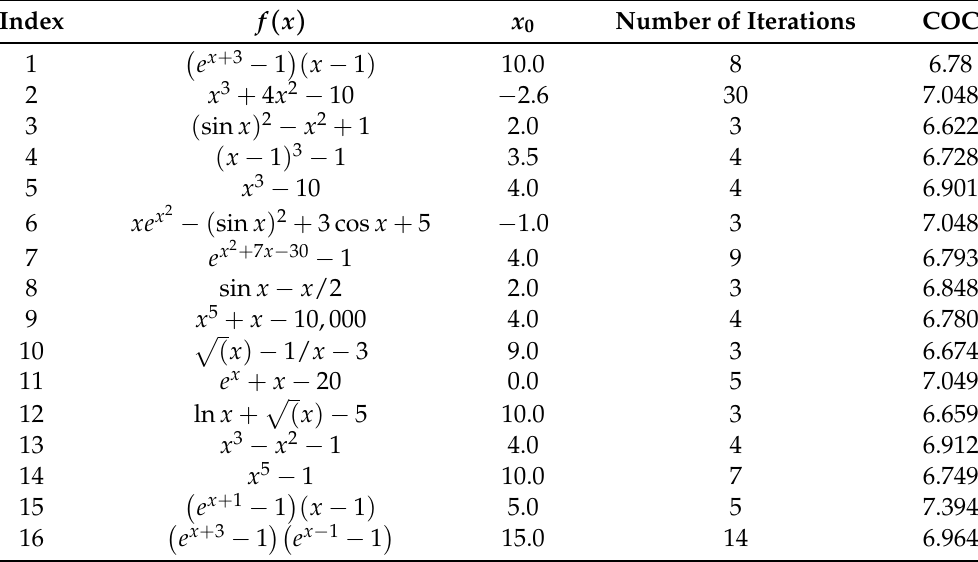
Table 1. Computational order of convergence for several functions using our new